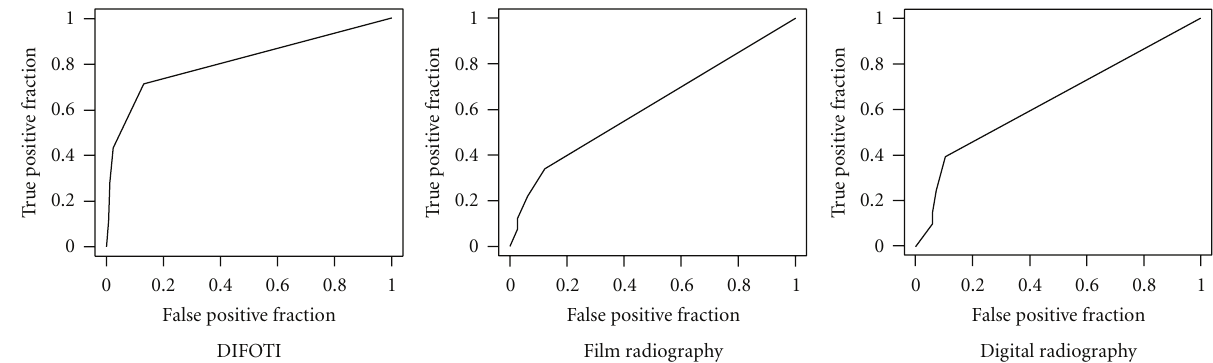
Figure 2: ROC curves for the three methods based on results from 8 observers at the diagnostic threshold D1 (enamel and dentin caries).